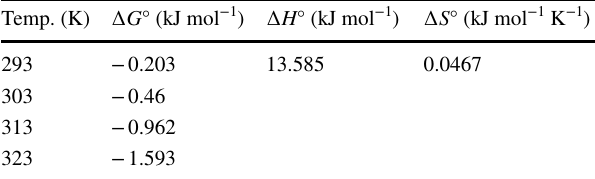
Fig. 8 Plot of ∆ G ° versus T Table 6 Sorption thermodynamic